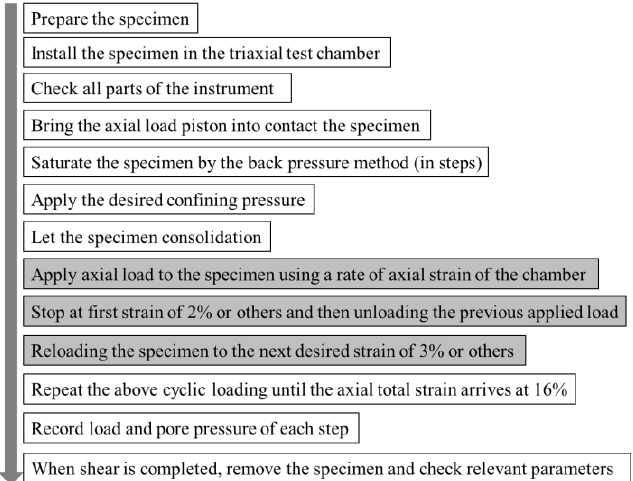
Figure 3. Test procedure for the consolidated undrained (CU) test in the laboratory under cyclic loading.